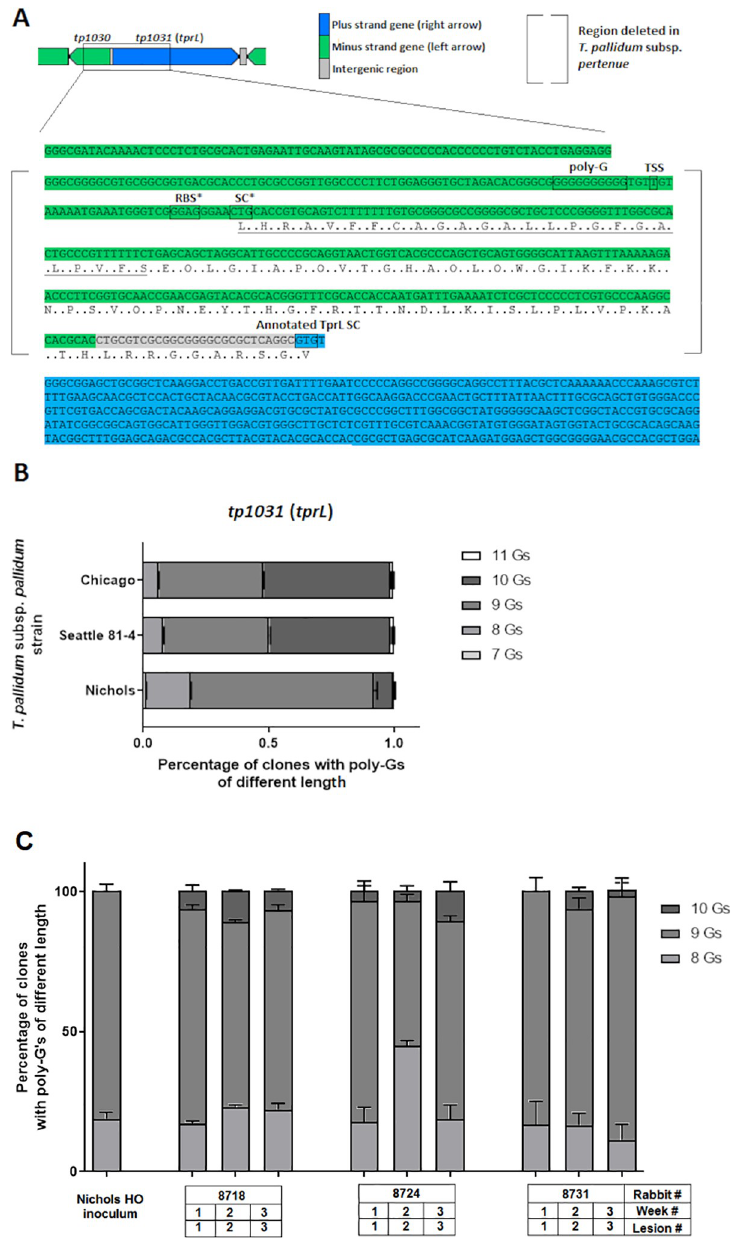
Fig 2. ( A ). Cartoon depicting the tprL ORF as originally annotated in the T . pallidum Nichols strain [31] (blue) showing the location of the homopolymeric G tract (poly-G), the experimentally determined TSS. Asterisks indicate the newly predicted ( � ) TprL ribosomal binding site (RBS) and start codon (SC) based on the TSS identification. According to this model, the TprL ORF encompasses 88 additional amino acid residues located upstream of the annotated SC. Within these residues, a cleavable signal peptide (underlined) is predicted by three independent programs (SignalP, PrediSi and LipoP). ( B ). Distribution of poly-G lengths in the Nichols, Chicago, and Seattle 81–4 treponemes at the moment of bacterial harvest determined by FFLA. ( C ). FFLA results of the tprL -associated poly-G are shown for the clonal strain Nichols Houston O inoculum and treponemes found in lesions after ID infection with that inoculum. Data are shown for lesions from three rabbits over a three-week